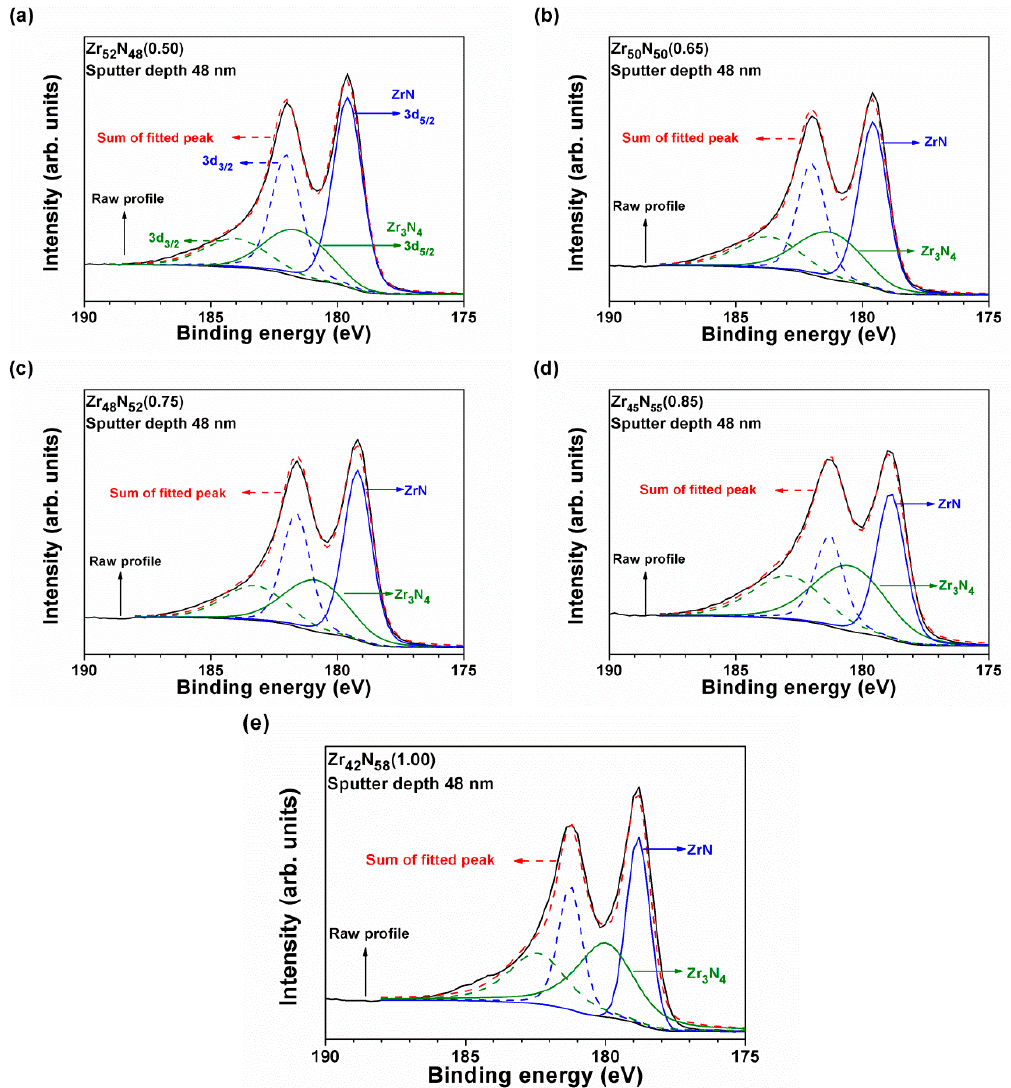
Figure 6. Curve fitting of the Zr 3 d signals of ( a ) Zr 52 N 48 (0.50), ( b ) Zr 50 N 50 (0.65), ( c ) Zr 48 N 52 (0.75), ( d ) Zr 45 N 55 (0.85), and ( e ) Zr 42 N 58 (1.00) films at depths of 48 nm.